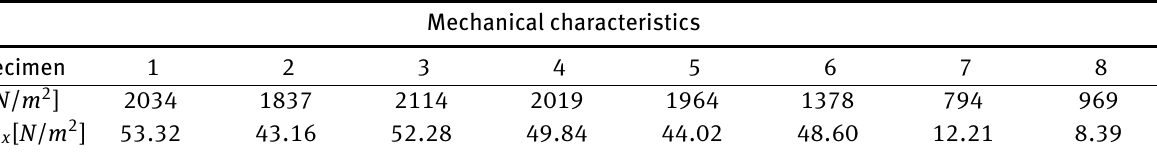
Table 4: Flexural modulus of elasticity and flexural strength for the eight proposed specimens.